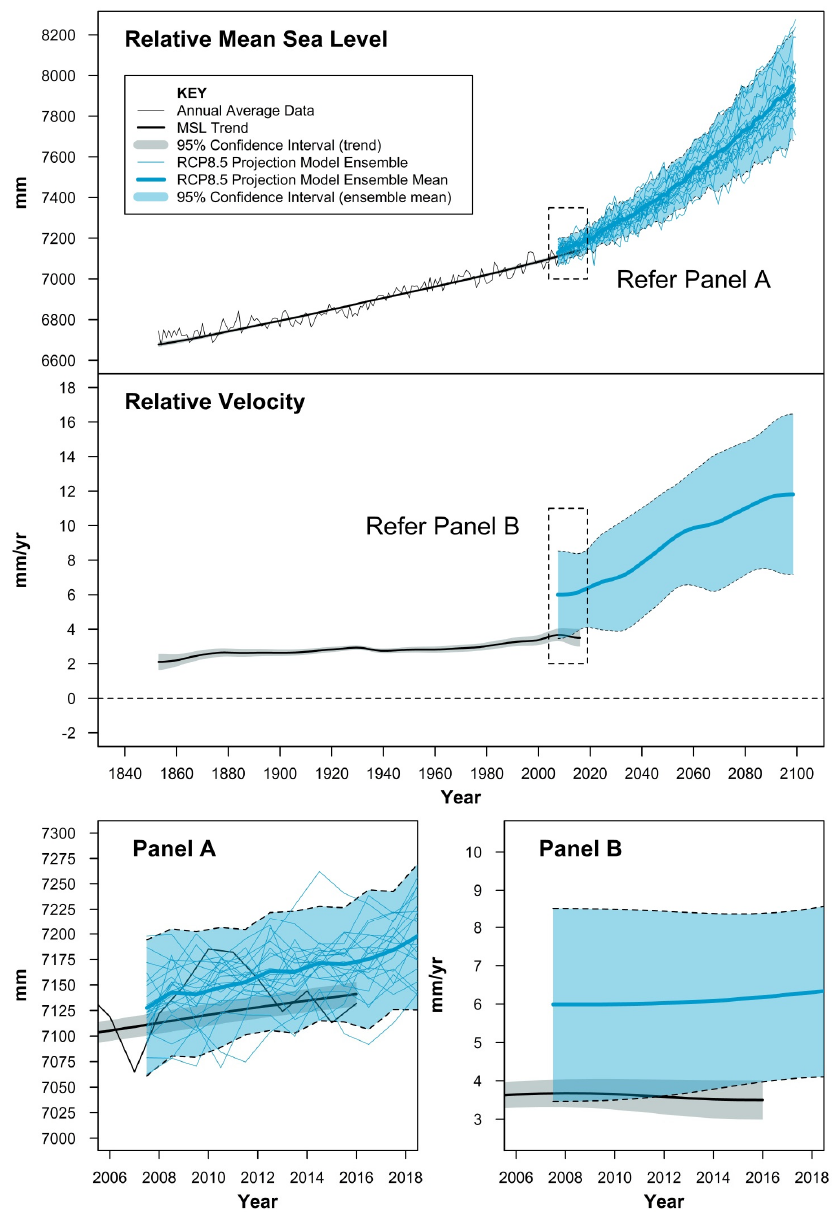
Figure 5. Integrating estimated mean sea level and associated velocity for the Battery Park (New York) tide gauge record with CMIP5 projection modelling (RCP8.5).